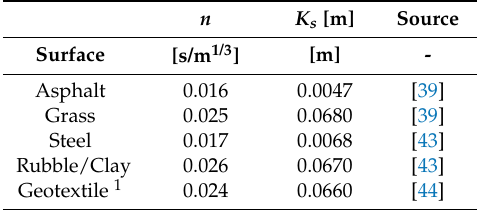
Table 2. Roughness coefficients used for both road and crest models from [39].